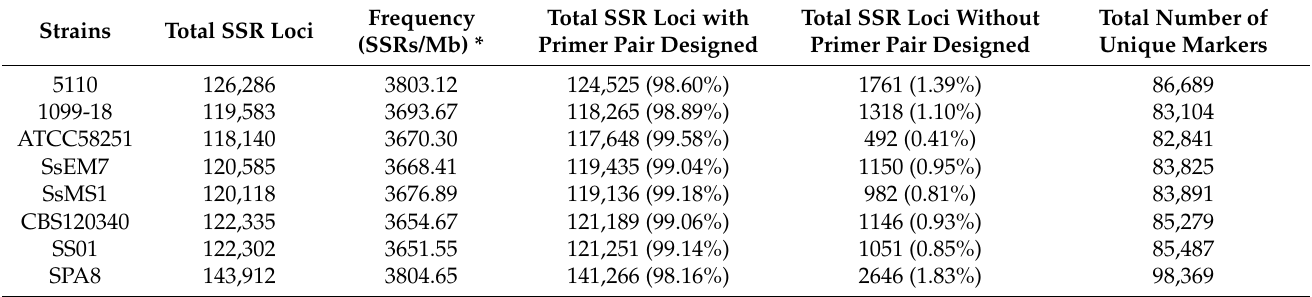
Table 1. Statistics for genome-wide retrieved SSRs in Sporothrix